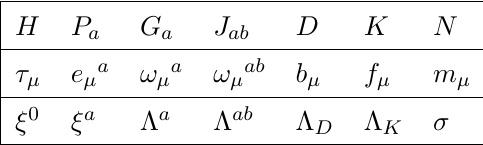
Table 1 . Schr(cid:127)odinger gauge (cid:12)elds and